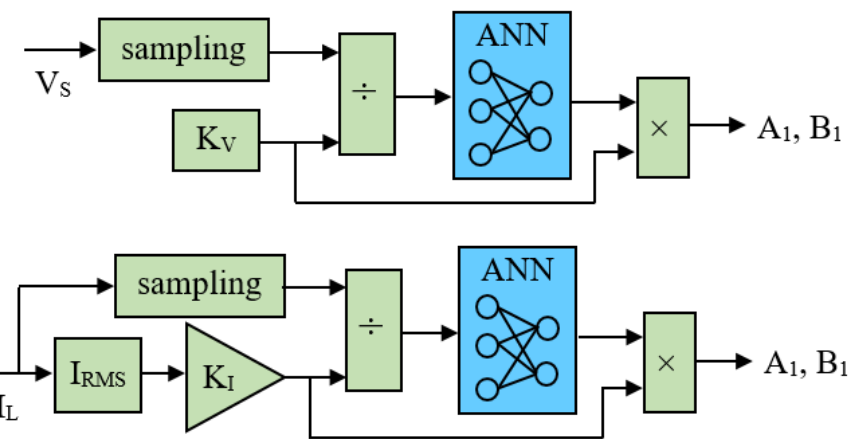
Figure 5. Scaling of the ANN input signals, converting them into values that do not significantly exceed the ± 1 range, allowing ANN performance optimization.